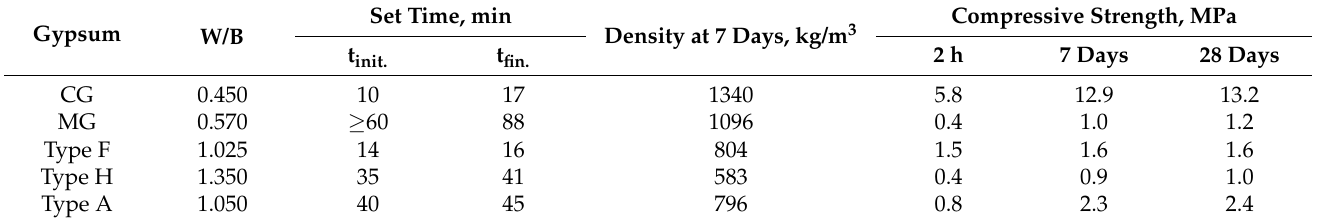
Table 6. Properties of commercial gypsum and CDW gypsum binder treated for 4 h at 180 ◦ C.